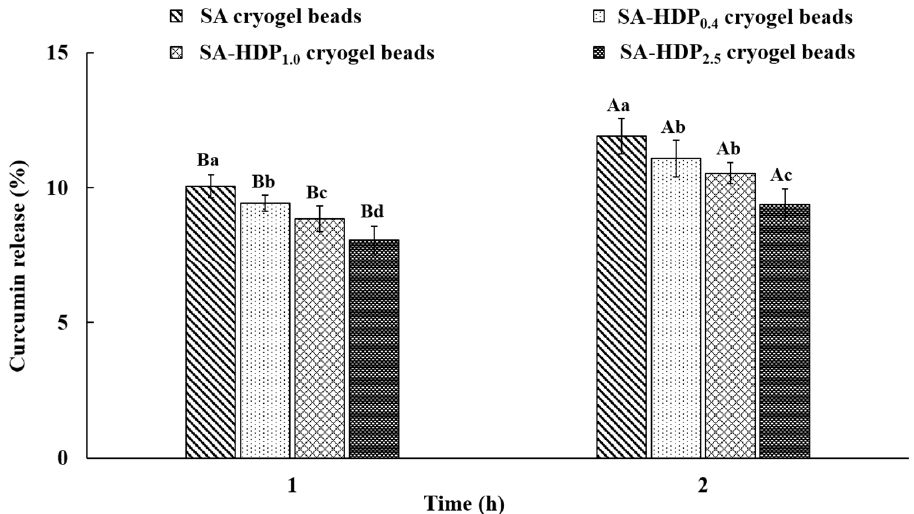
Figure 6. In vitro gastrointestinal tract release properties of sodium alginate (SA)-based cryogel beads filled with different concentrations of hydroxypropyl distarch phosphate (HDP) in simulated gastric fluid (SGF). SA cryogel beads, SA-HDP 0.4 cryogel beads, SA-HDP 1.0 cryogel beads, and SA-HDP 2.5 cryogel beads represent cryogel beads filled with different concentrations of HDP (0, 0.4, 1.0 and 2.5%, respectively). Small letters show significant differences between treatment at the same time ( p < 0.05), and capital letters show significant differences between times for the same treatment ( p < 0.05).